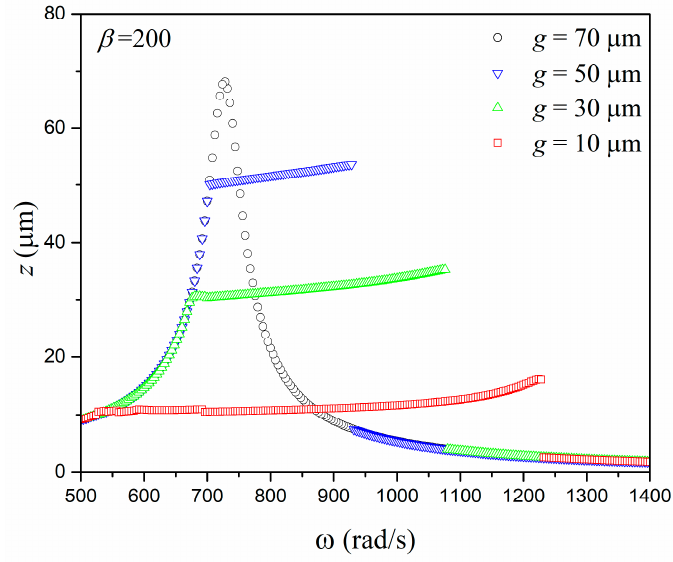
Figure 4. Maximum displacement versus forcing frequency β = 200 with different gap values, g.